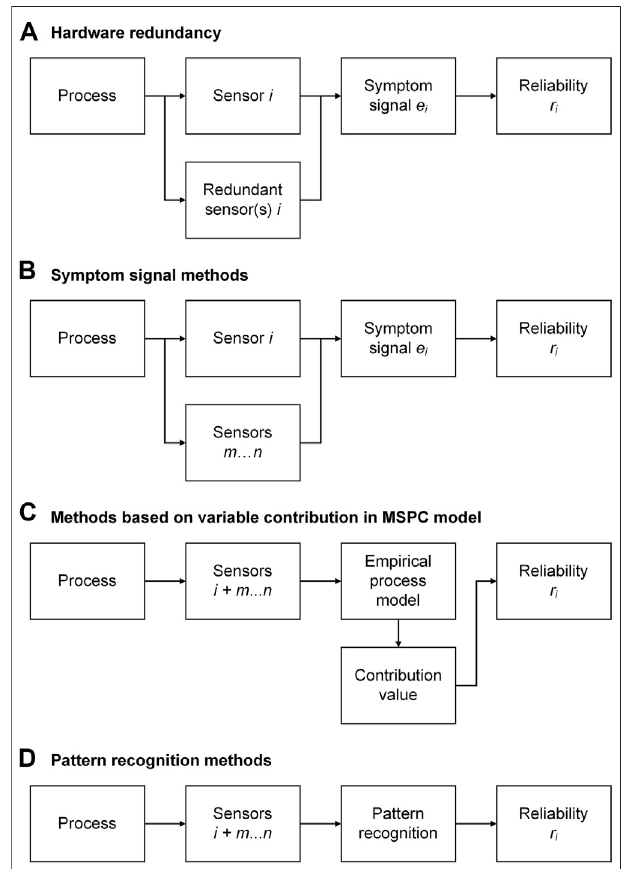
FIGURE 4 | Approaches for sensor fault detection: (A) hardware redundancy; (B) symptom signal methods; (C) methods based on variable contribution in MSPC model; (D) pattern recognition methods. The index i refers to one type of sensor for one physical or chemical variable, whereas m ... n refers to any other types of sensors. For example, in (A) , the reliability of one turbidity sensor (sensor i ) is determined using other turbidity sensors in the same bioreactor (redundant sensors i ). In (B) , the reliability of a turbidity sensor (sensor i ) is determined using other sensors such as exhaust gas, dissolved oxygen, and pH (sensors m ... n ). In (C,D) , the entire process datamatrixconsistingoftheturbiditysensortobemonitored(sensor i )andthe othersensors( m ... n )isused asinputtotheempirical processmodel (C) and pattern recognition (D) , respectively. Approaches (B – D) are based on analytical